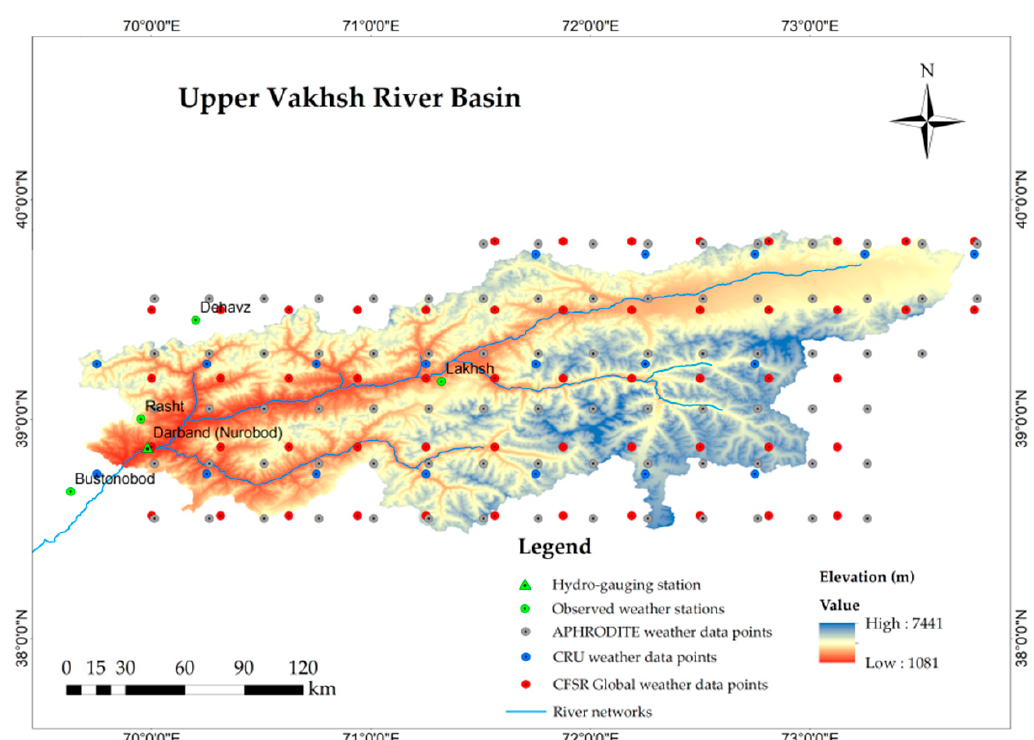
Figure 1. The digital elevation model of the Upper Vakhsh River Basin in Central Asia, with the locations of the observed weather and hydro-gauging stations, Climatic Research Unit (CRU), Asian Precipitation Highly Resolved Observational Data Integration Towards the Evaluation of Water Resources (APHRODITE), and Climate Forecast System Reanalysis dataset (CFSR), as well as the global weather data points and streamflow.